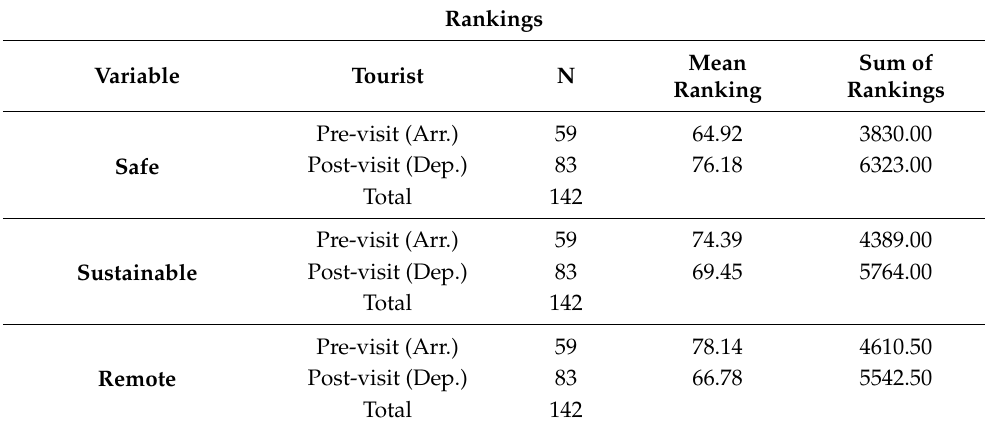
Table 2. Pre-and post-experience destination image of the Faroe Islands, PS Imago Pro, own elabo- ration.